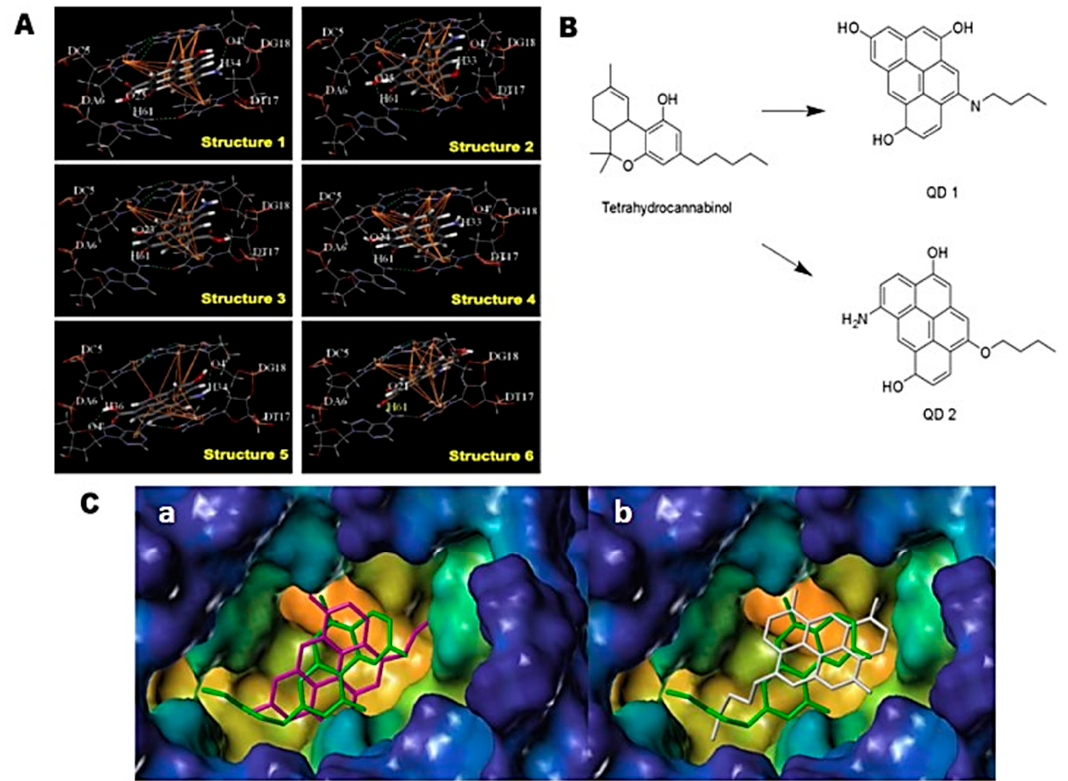
Figure 1. ( A ) Hydrogen bonding and π - π interactions between AG-QDs with DNA at select binding sites. Green dotted lines show H-bonds between AG-QDs and basic groups, purines and pyrimidines. Yellow lines show π - π interactions between AG-QDs and basic groups (cytimidine, guanine, adenine, and thymine). Carbon, oxygen, hydrogen, and nitrogen are colored in grey, red, white, and blue, respectively. ( B ) Comparison of the structures of Marijuana and designed Quantum dots. The formation of the cQD from marijuana results in a greater number of sp2 carbons. In turn, this will increase the hydrophobicity of the designed ligand and thereby increase lipophilic interactions with the CB1 receptor for hydrophobic binding subsites near CB1. It also not only makes the cQD a better free radical scavenger but also assists in tracking (via fluorescence imaging). ( C ) Docking of Tetrahydrocannabinol(green), and designed Quantum dots (generated “ in silico ” to potentially bind to the CB1 receptor) in CB1 receptor a) Tetrahydrocannabinol (green) and QD 1 (pink) b) Tetrahydrocannabinol (green) and QD 1 (white). The “cQD”s were docked through CB1 crystal structure (PDB:5TGZ) using SYBYL-X with Surflex-Dock program. Both QD1 (pink), and QD2 (white) were superimposed very well in CB1 binding site, compared to Tetrahydrocannabinol (green). The pockets were filled such that the free energy reached a minimum value e ff ectively (suggestive of a global minima). A part of this Figure is adapted from